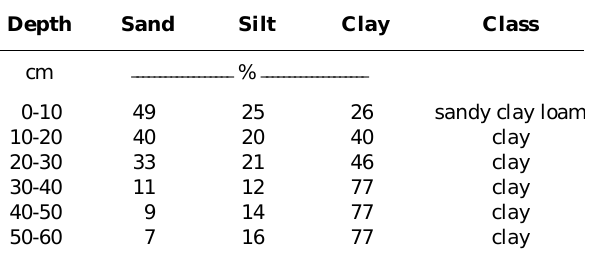
Table 1. Textural class based on the USDA system for six 10 cm thick layers